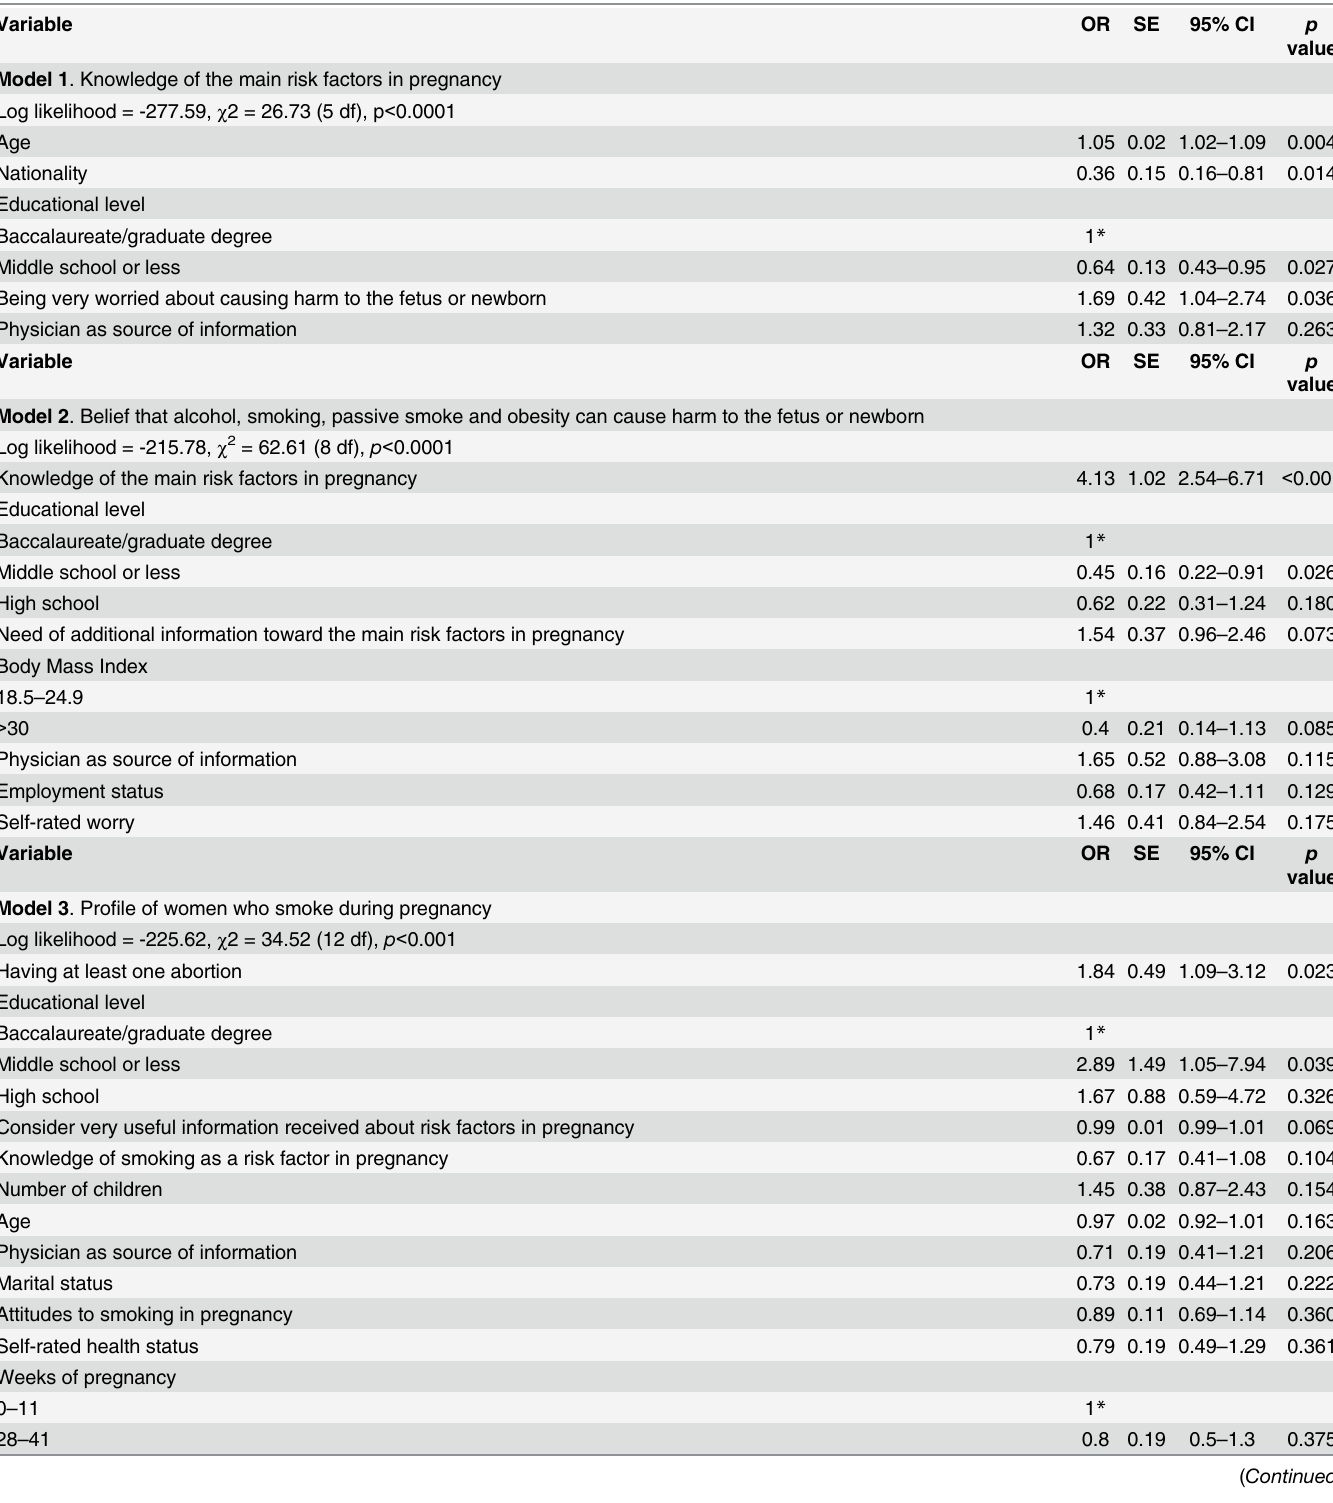
Table 2. Multivariate logistic regression analyses indicating associations between several variables and the different outcomes regarding main risk factors in